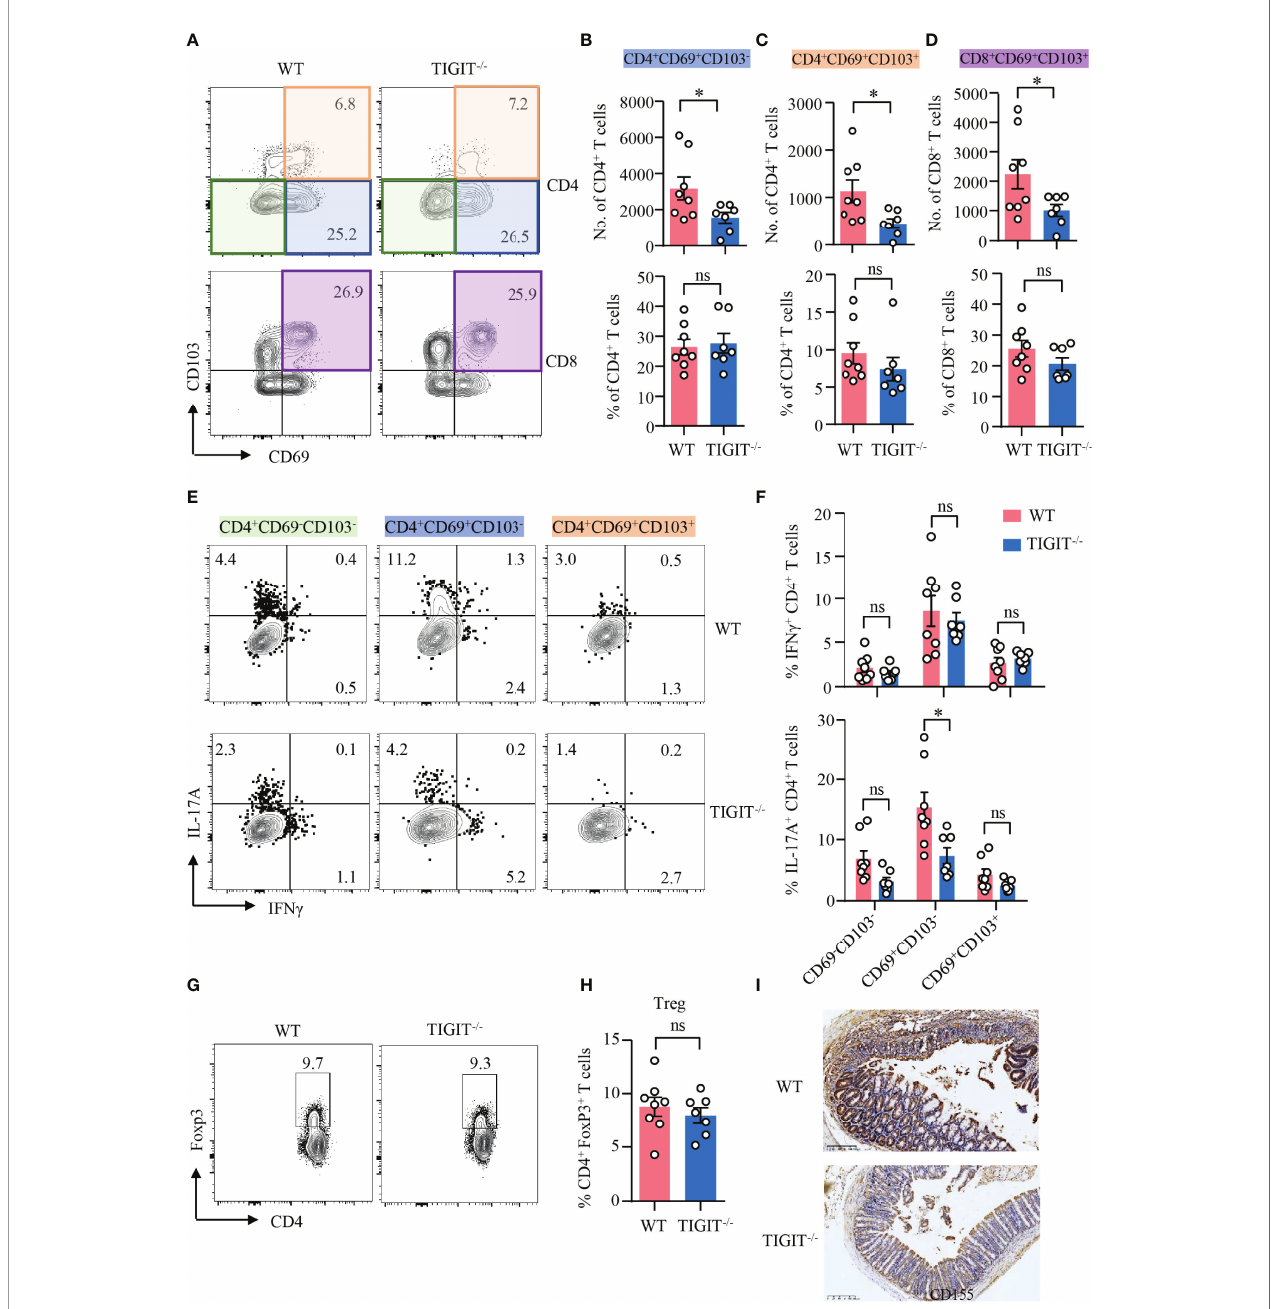
FIGURE 5 | TIGIT de fi ciency reduced IL-17A – producing CD4 + CD69 + CD103 − T cells in DSS-induced colitis. DSS-induced colitis was established as in Figure 1 . LPMCs were isolated from colon of TIGIT − / − or WT mice with DSS-induced colitis. (A – D) CD69 and CD103 expression in CD4 + and CD8 + T cells in LPMC from TIGIT − / − or WT mice was measured by fl ow cytometry. Representative counter plots for CD69 and CD103 expression were shown. (B) Numbers and frequencies of CD4 + CD69 + CD103 − T cells. (C) Numbers and frequencies of CD4 + CD69 + CD103 + T cells. (D) Numbers and frequencies of CD8 + CD69 + CD103 + T cells. (E) IFN g and IL-17A expression in CD4 + T cells from LPL was measured by fl ow cytometry. Representative fl ow cytometry of IFN g and IL-17A expression of CD4 + CD69 − CD103 − T cells, CD4 + CD69 + CD103 − T cells, or CD4 + CD69 + CD103 + T cells. (F) Frequencies of IFN g + and IL-17A + T cells among CD4 + CD69 − CD103 − T cells, CD4 + CD69 + CD103 − T cells, or CD4 + CD69 + CD103 + T cells. (G, H) FoxP3 expression in CD4 + T cells from spleens of TIGIT − / − or WT mice was measured by fl ow cytometry. Percentages of FoxP3 + CD4 + T cells were summarized and representative counter plots were shown. (I) Colon sections from TIGIT − / − or WT mice with DSS-induced colitis were stained with antibody against CD155 and visualized using HRP-conjugated secondary antibody. Representative images of CD155 staining by immunohistochemistry were shown. Original magni fi cation: ×10. Data are means ± SEM. WT = 8, TIGIT − / − = 7. * p < 0.05 by Student ’ s t -test. ns, not signi fi